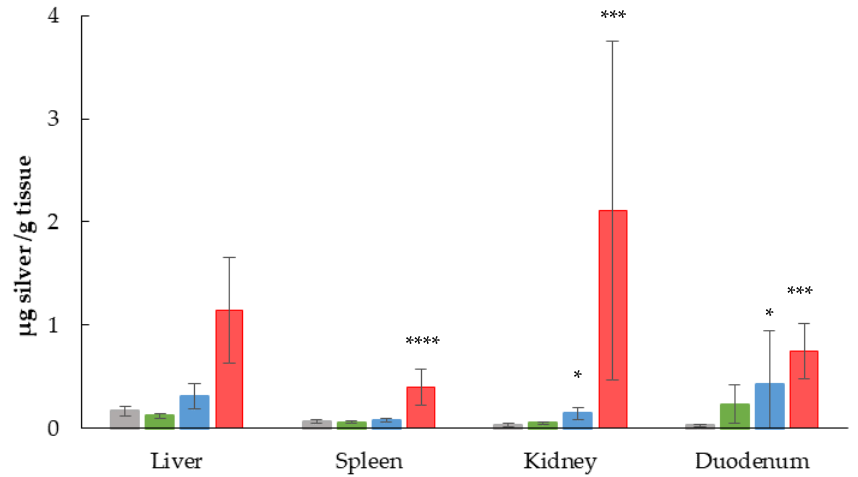
Figure 4. Results of the silver content in frozen samples of liver, spleen, kidney, and duodenum after 28-day oral administration of the silver-kaolin formulation. The graphic shows the mean silver content ± SD of each organ and group (grey: negative control, green: 50 mg/kg b.w., blue: 300 mg/kg b.w., red: 2000 mg/kg b.w.). * ( p < 0.05), *** ( p < 0.005), **** ( p <